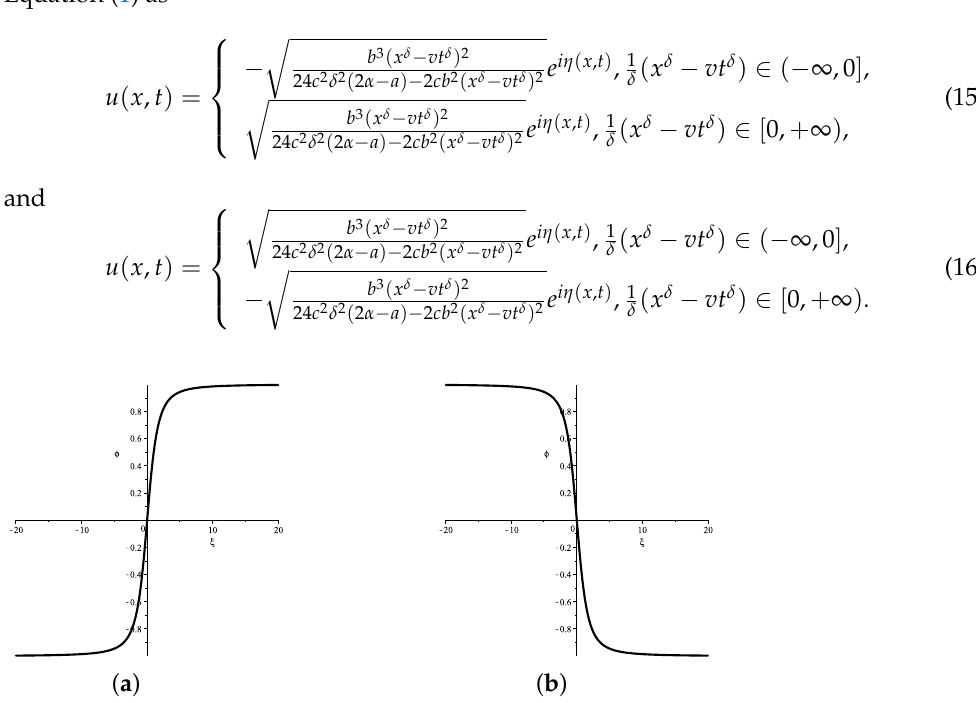
Figure 7. Kink and anti-kink wave forms of system (5). ( a ) Kink wave. ( b ) Anti-kink